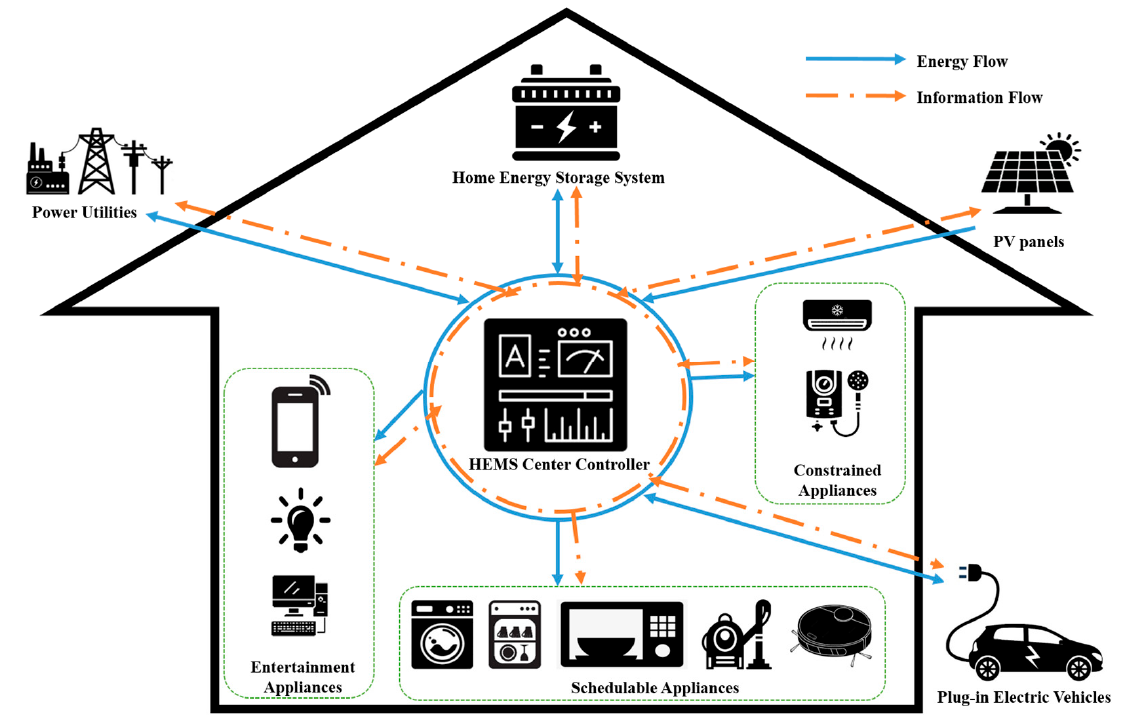
Figure 2. Layout of the home energy management system.